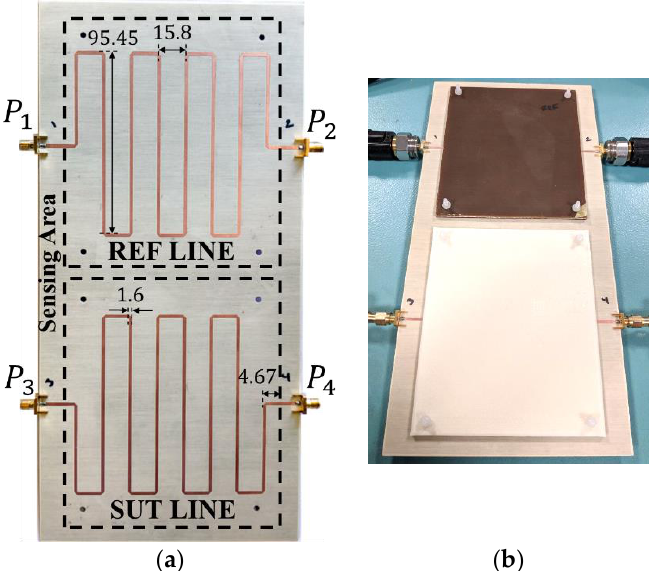
Figure 2. Photograph of the differential-mode phase variation sensor based on a pair of meandered lines, without ( a ) and with ( b ) REF and MUT (or SUT) samples on top of it (dimensions are given in mm). Reprinted with permission from [37].